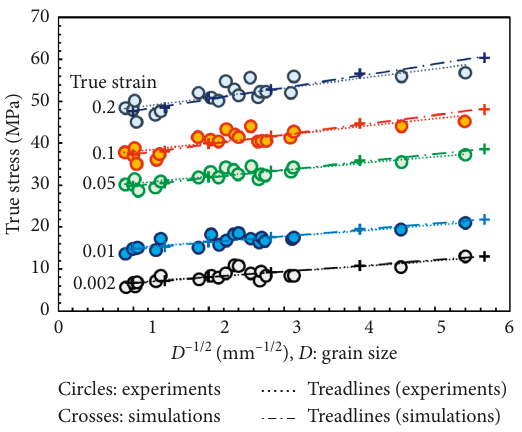
Figure 5: Hall–Petch plot for pure aluminium from experiments [25] and simulations. Figure Table 3: Hall–Petch constants for pure aluminium from experi- ments [25] and simulations. Experiments [25] Simulations True strain